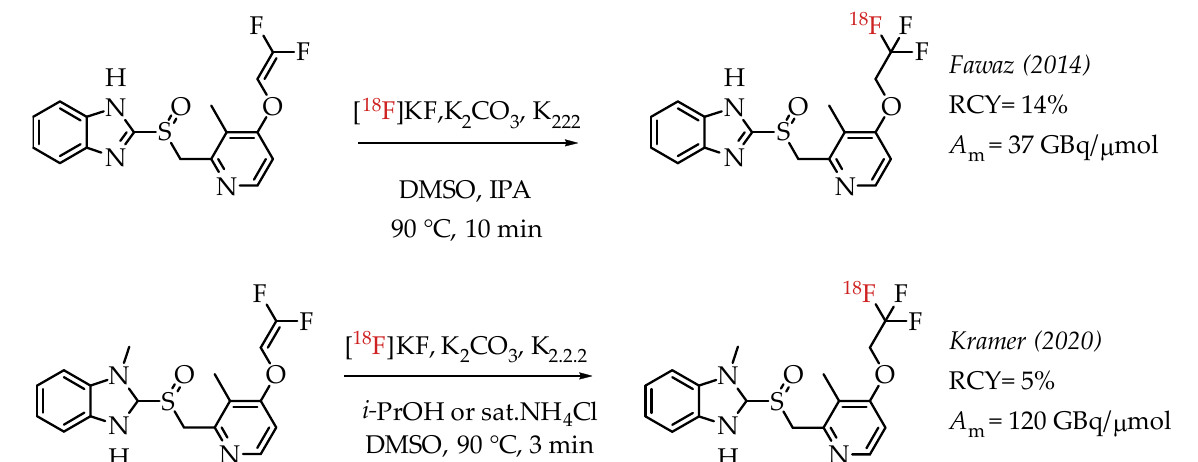
Figure 7. Transversal, sagittal, and coronal view of averaged PET images of [ 18 F]AV1451 and [ 18 F]NML uptake in two AD patients 90–110, 80–100, and 60–90 min p.i., respectively. (Images taken from reference [45]).